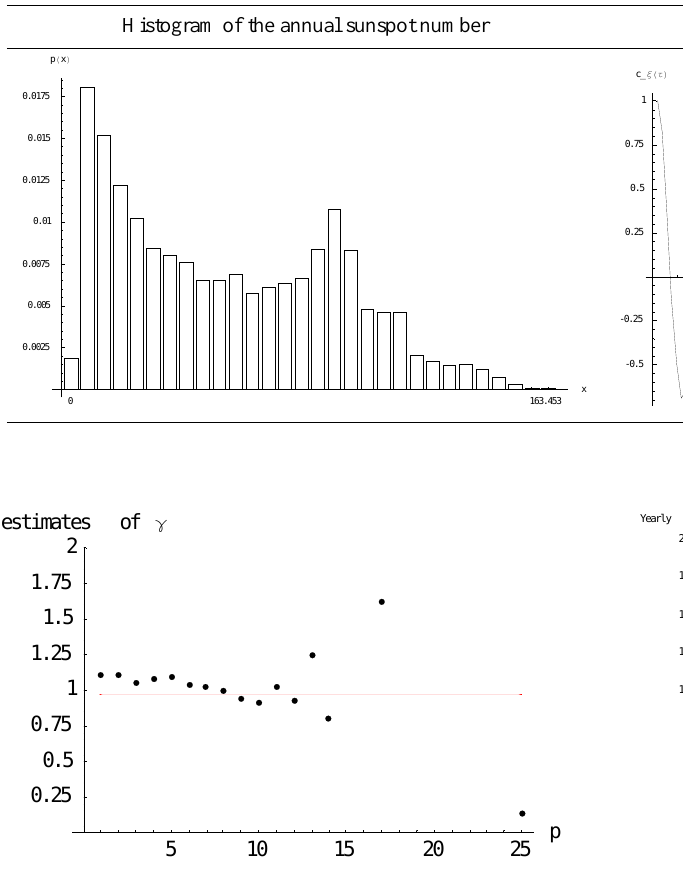
= 0 . 9707 Fig. 15. The 8 last cycles #16–23 plotted for the 7 most probable au- 23 toregression values in comparison with the actual historical record s(t) (red